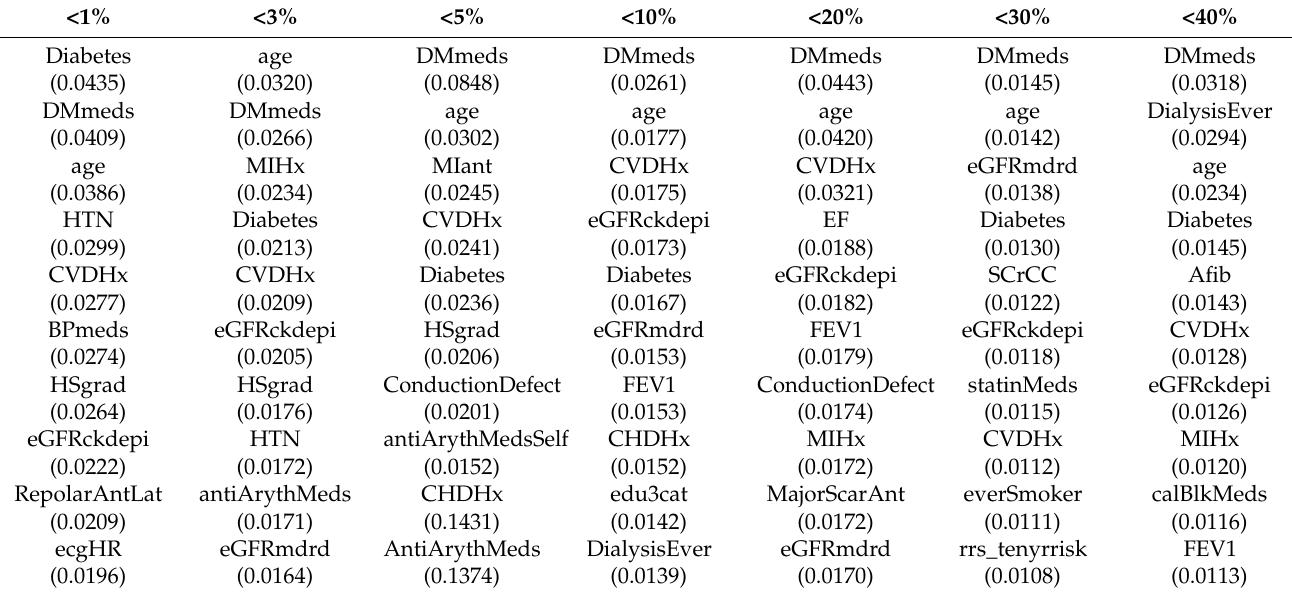
Table 4. The selected parameters of the final HF prediction model for XGBoost using KNN